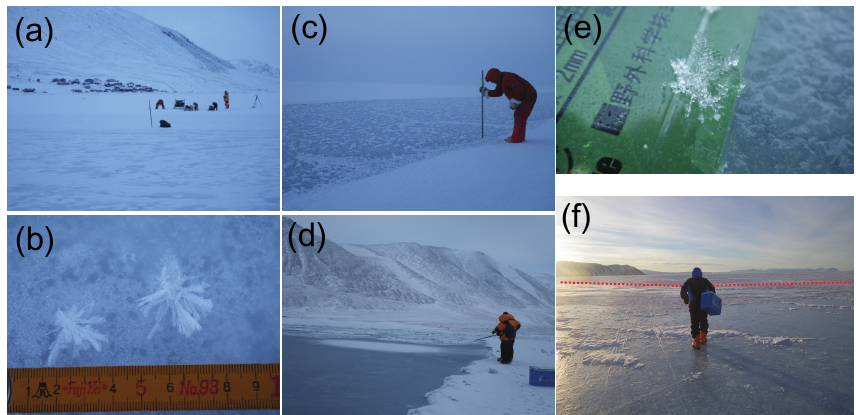
Figure 3. Photographs of (a) sea-ice and frost flower conditions on 20 February at site I, (b) frost flowers at site I on 22 February, (c) frost flowers at site II, (d) sea-ice conditions at site IIIa, (e) frost flowers on 4 March at site IIIa, and (f) old sea-ice conditions on 2 March immediately after the storm. Red dotted lines indicate approximate location of margin between old sea ice and young sea ice.